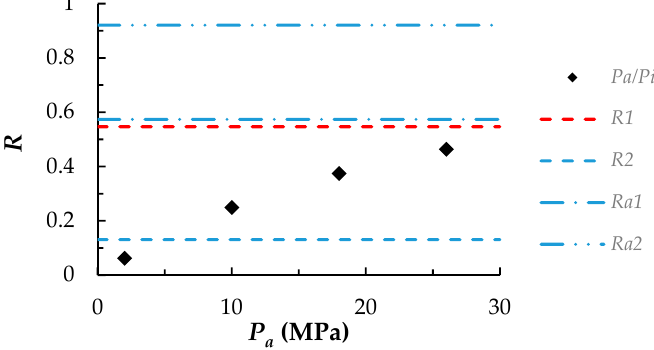
Figure 12. Pressure ratio as a function of ambient pressure under constant pressure difference of 30 MPa.